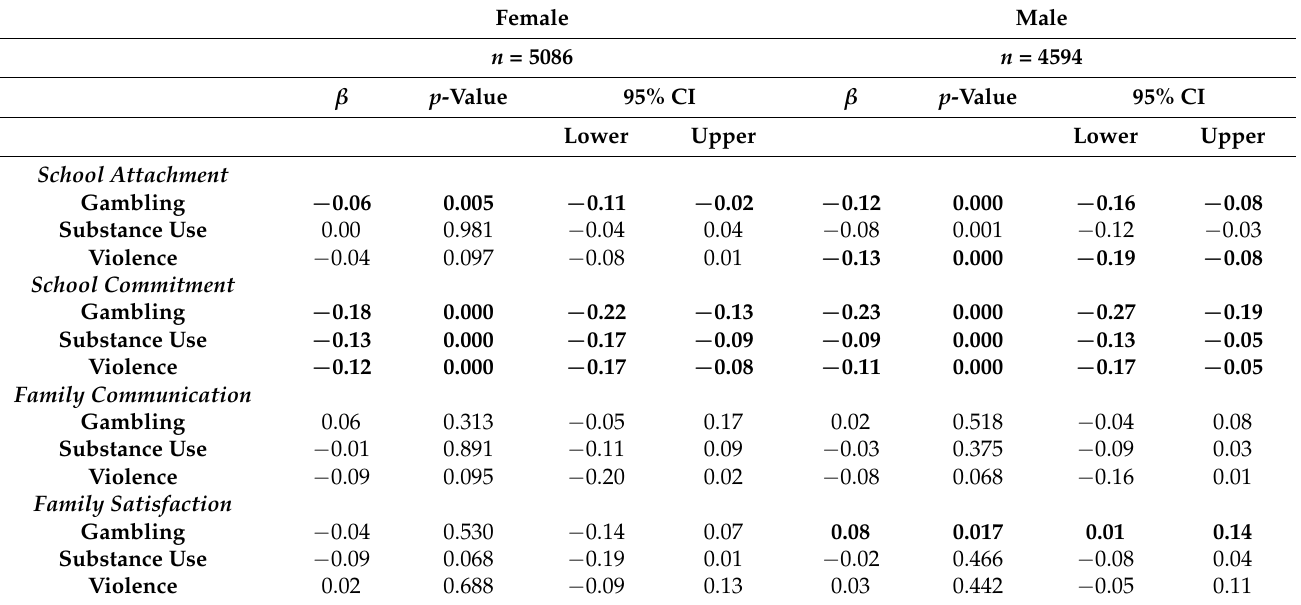
Table 2. Results of structural equations examining the association of family and school protective factors and family satisfaction with female and male students gambling, substance use, and violence. Female Male n =